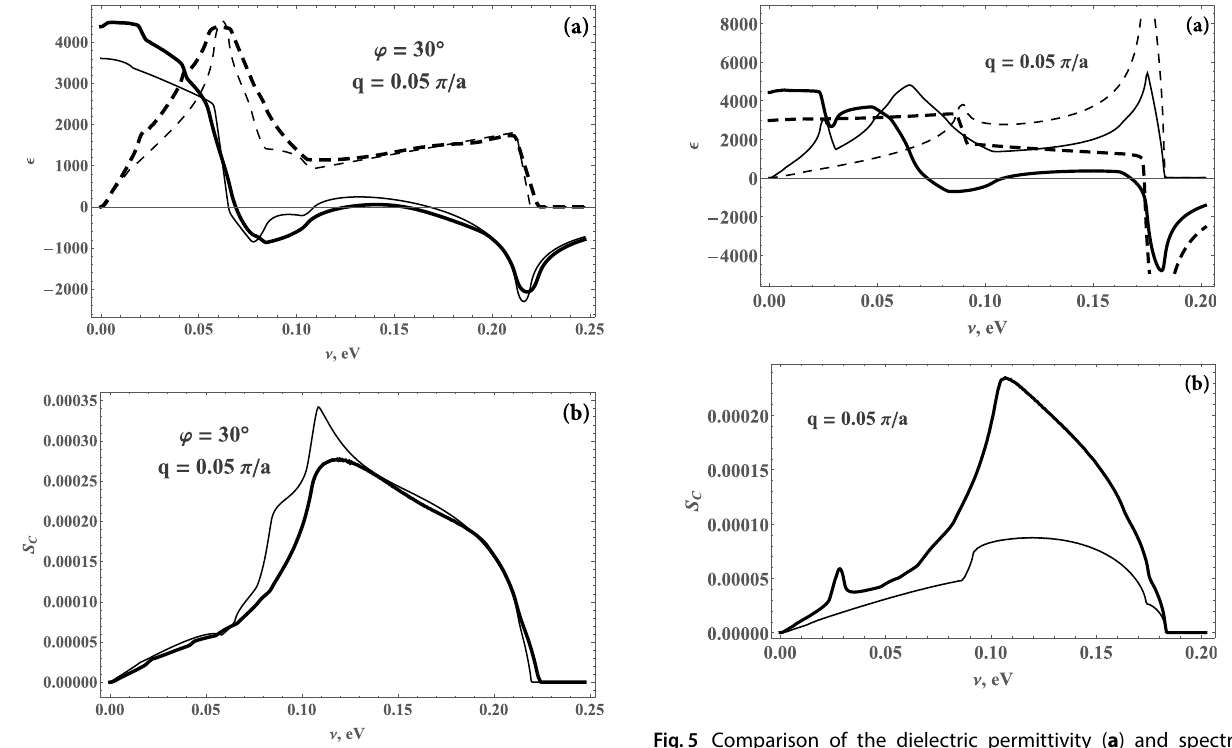
Fig. 5 Comparison of the dielectric permittivity ( a ) and spectral function of the screened Coulomb interaction ( b ) for the model conduction band of LaH 10 (thick curves) and conduction band of an fcc metal in the tight-binding approximation (thin curves) (quasi-momentum here is directed along the diagonal of the cubic cell of the reciprocal bcc lattice, see Fig. 2). Solid and dashed curves on ( a ) correspond to the real and imaginary parts of dielectric per- mittivity, correspondingly